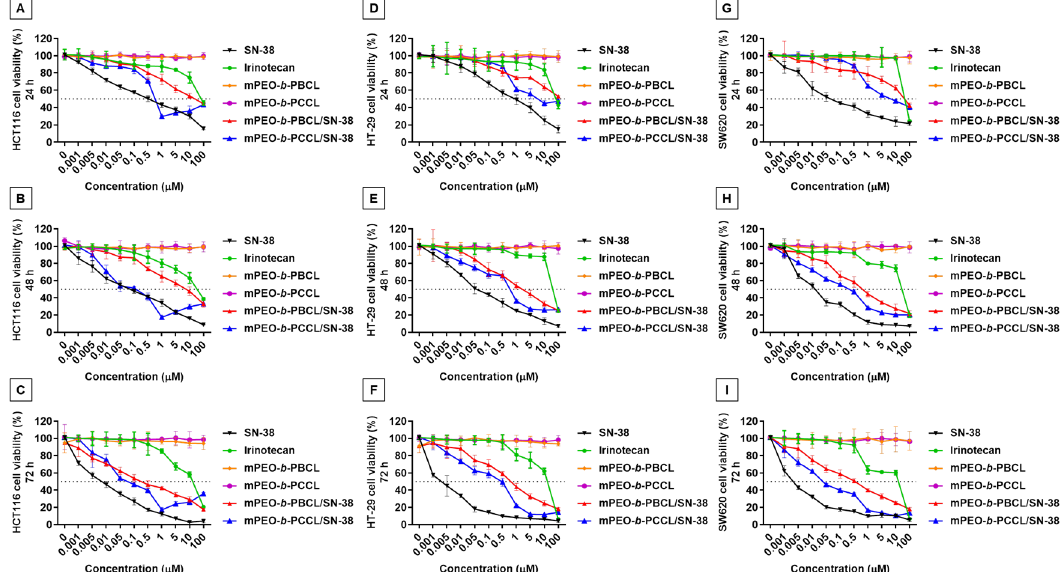
Figure 5. In vitro cytotoxicity assay for free SN-38 (black), irinotecan (green), mPEO- b -PBCL (orange),